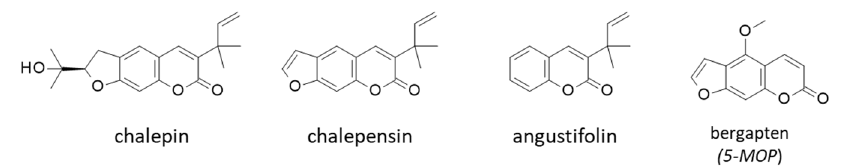
Figure 8. Structure of four coumarins found in R. angustifolia Pers.